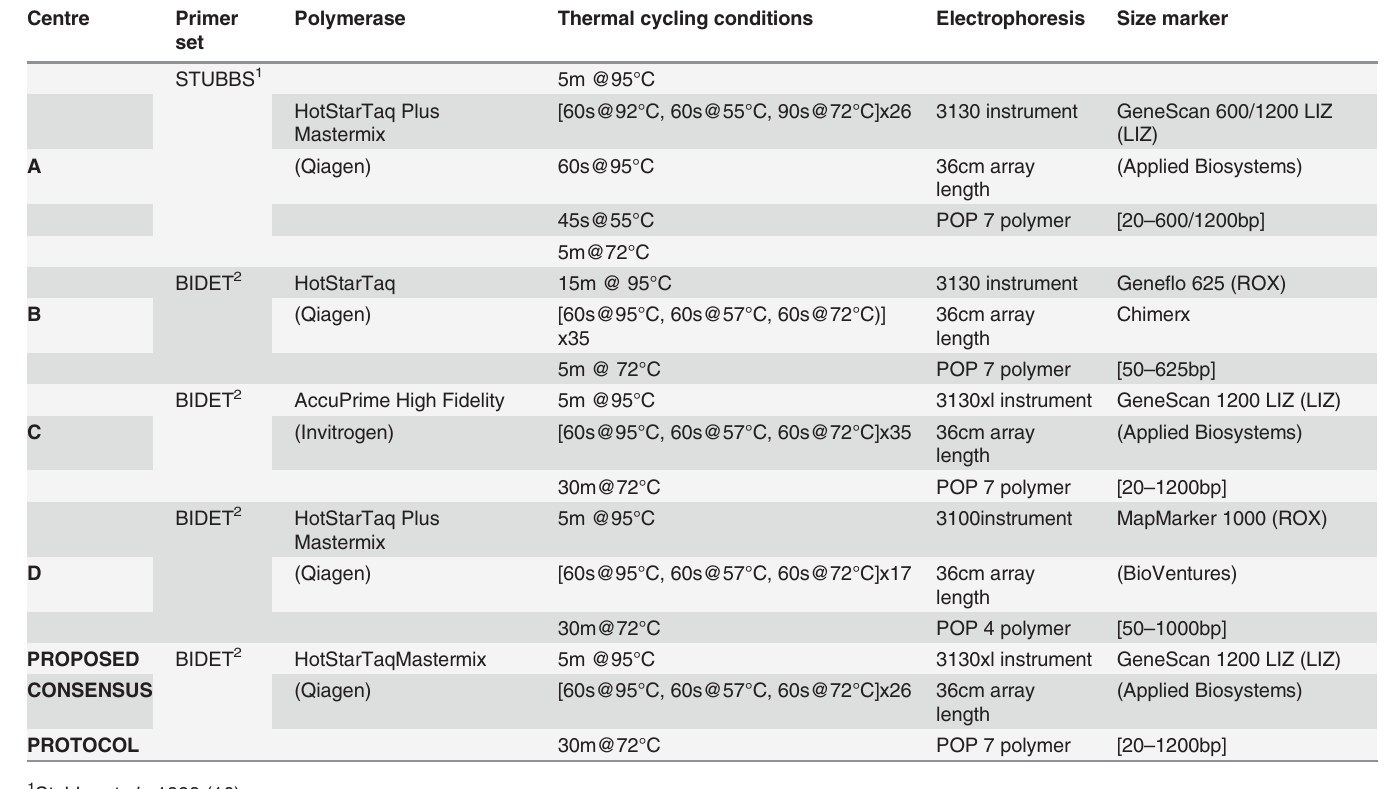
Table 2. Comparison of internal protocols from the four participating laboratories and the proposed consensus protocol.